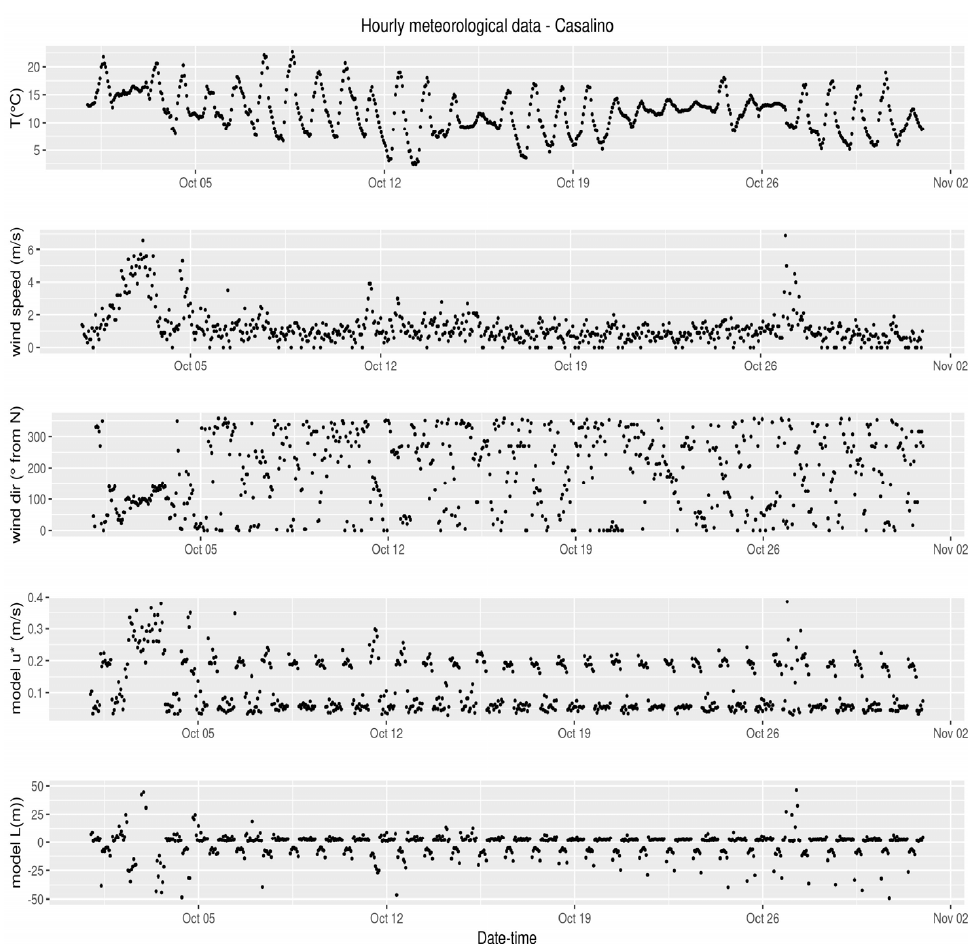
Figure 3. Time series of hourly air temperatures, wind speeds, and directions measured at the closest meteorological station, together with the model-derived values of u* and L. Data refer to the period